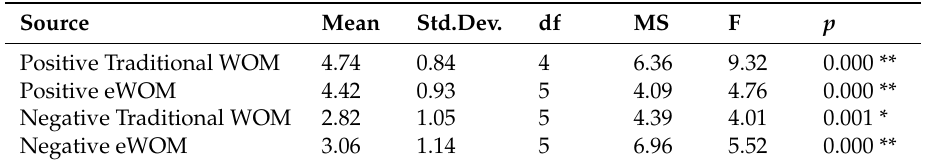
Table 5. ANOVA Results.